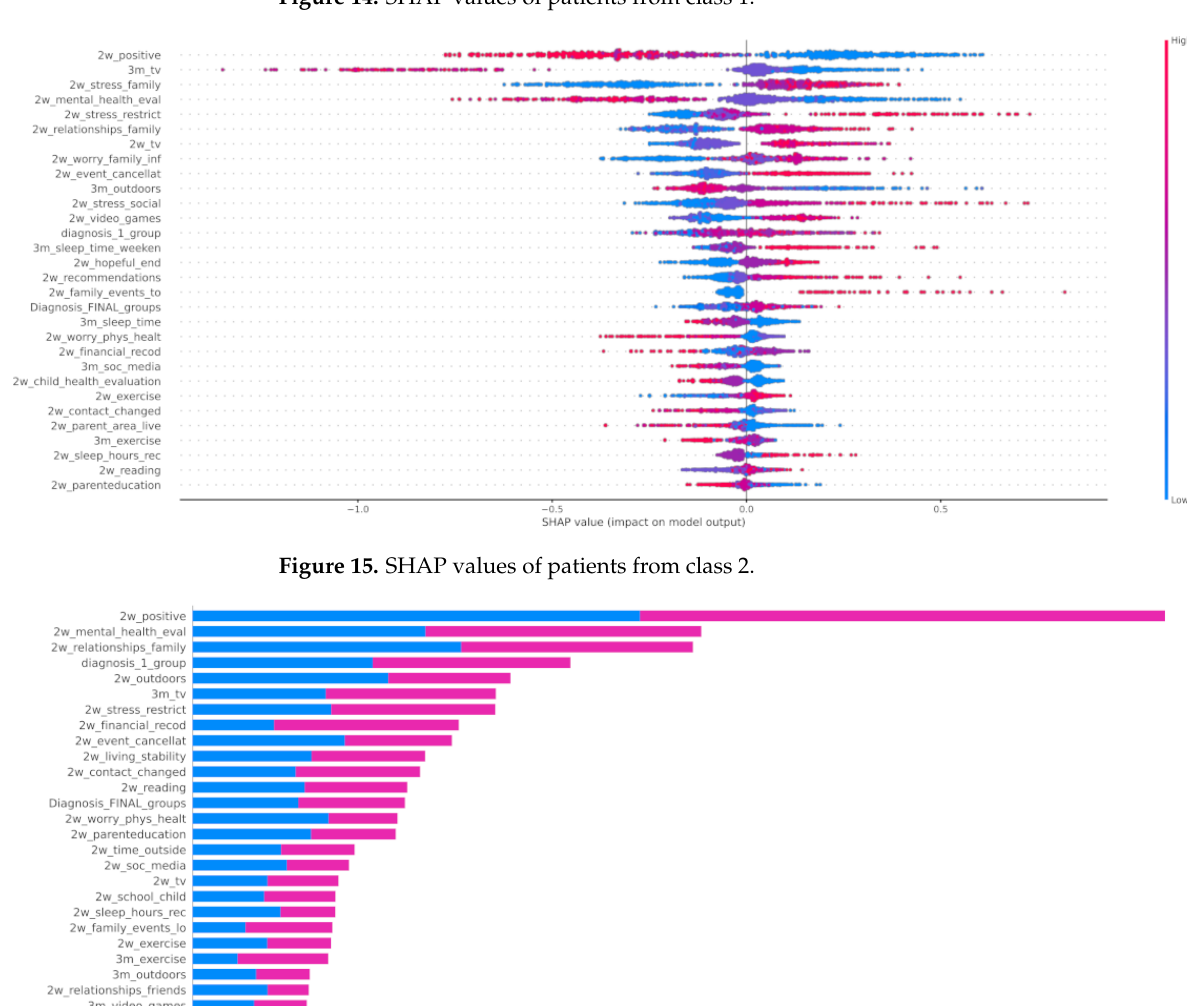
Figure 14. SHAP values of patients from class 1.